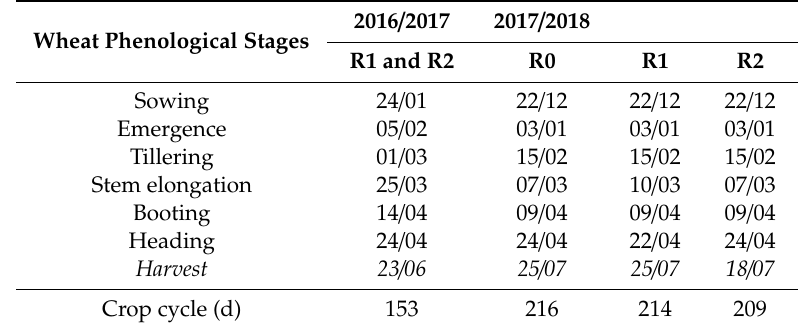
Table 1. Phenological states and their dates in the di ff erent water regimes in the 2016 / 2017 and 2017 / 2018